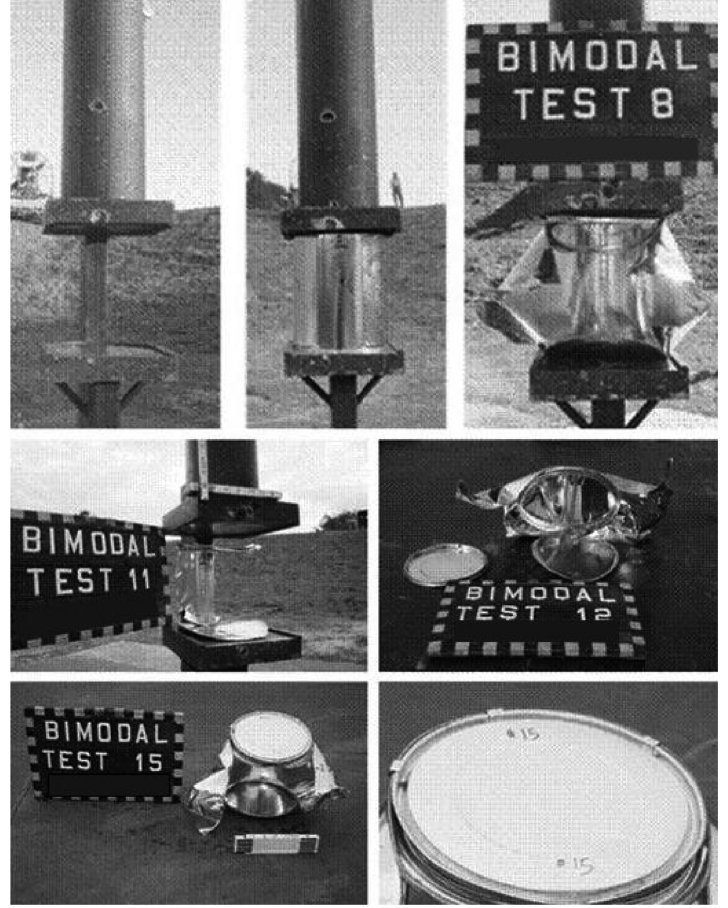
Fig. 3. Target structure and